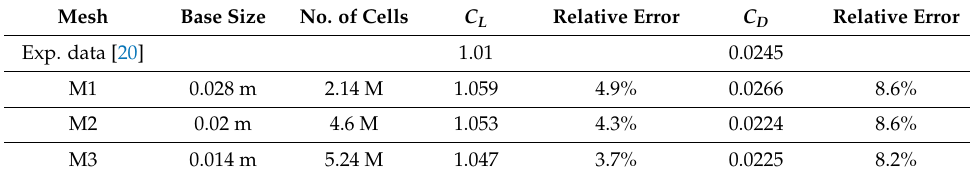
Table 2. Mesh independence study.